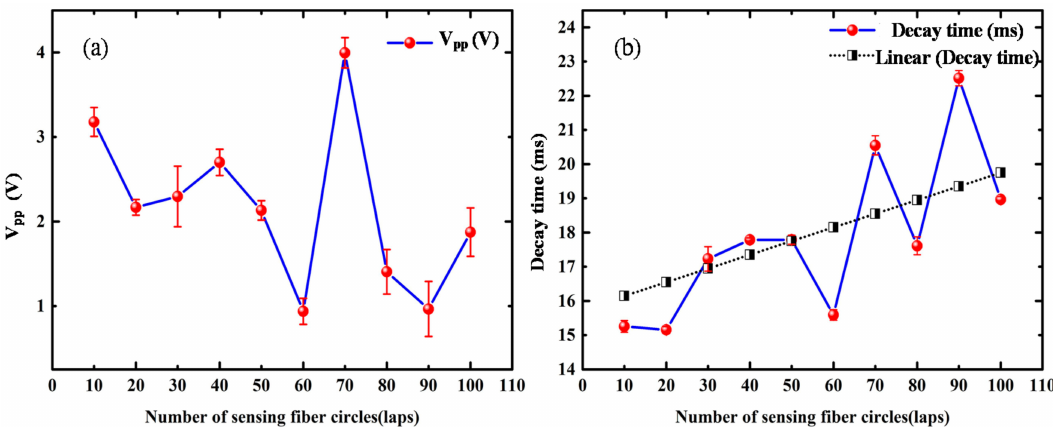
Figure 14. The variations of ( a ) V pp and ( b ) decay time versus the number of sensing fiber